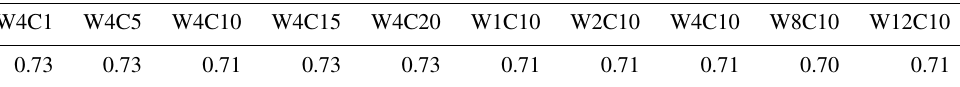
Table 2. Nash–Sutcliffe efficiency (NSE) of the TOPMELT-ICHYMOD model at different spatial aggregation and temporal resolution, from October 2001 to October 2007.